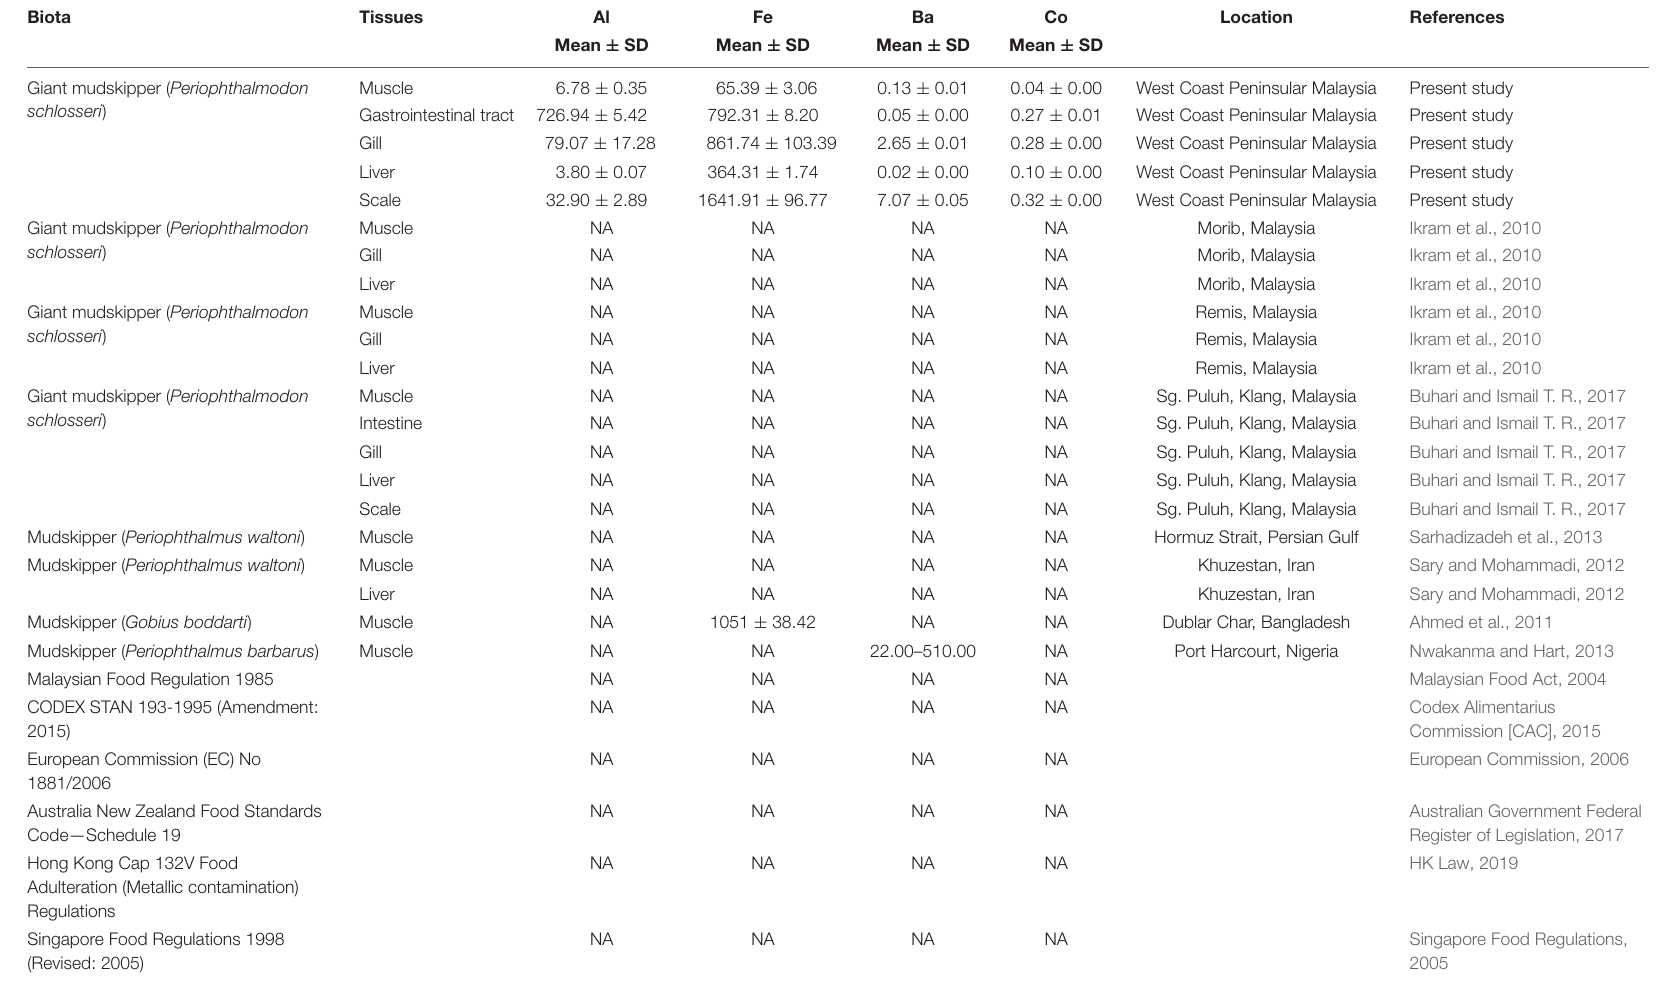
TABLE 3 | Comparison of elemental concentration (mg/kg) in giant mudskippers from current study with previous studies and guidelines.